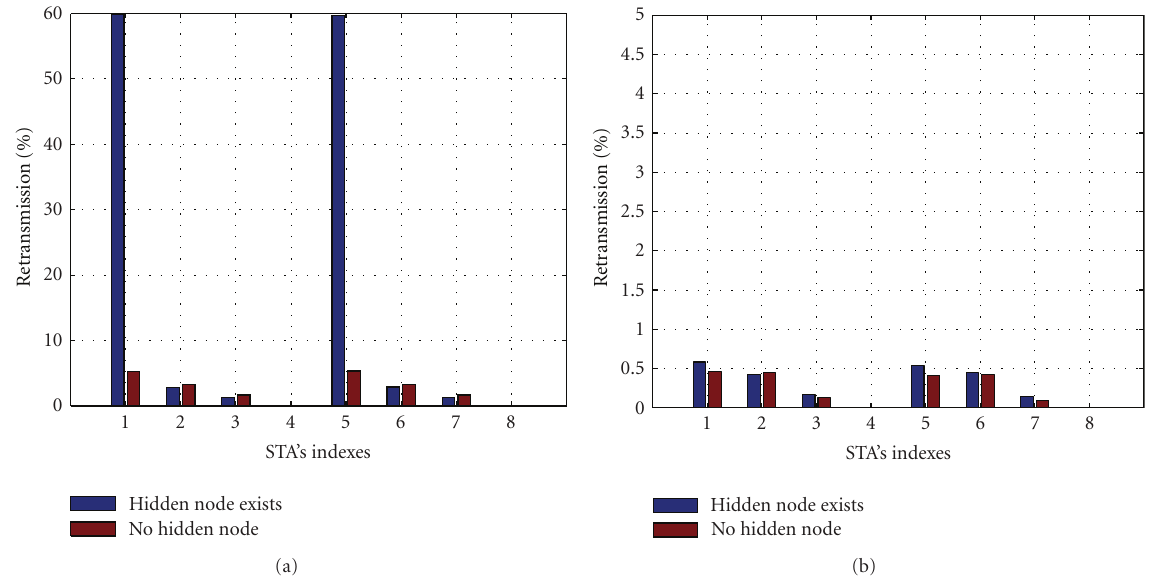
Figure 17: Percentage of retransmission of each STA at 50pps. (a) All STAs are in active mode. (b) All STAs are in PSM. At 50pps the impact of hidden node is negligible on PSM operation when compared with active